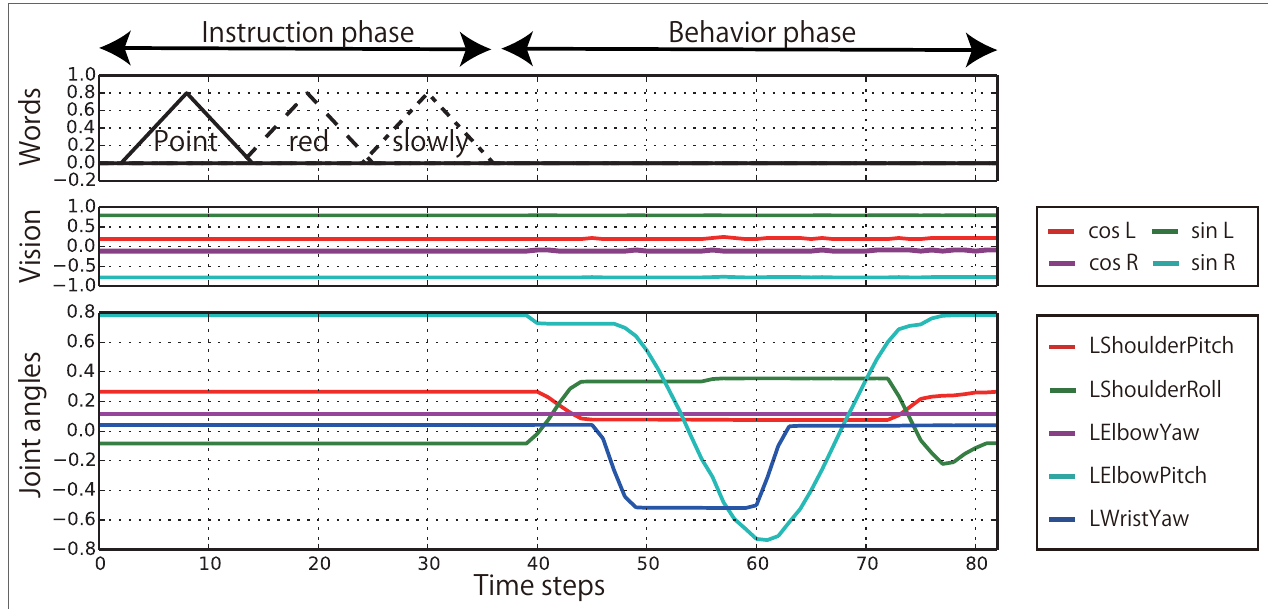
FIGURE 4 | An example of a target sequence representing an episode . In this episode, the robot generates the “POINT-LEFT-SLOWLY” behavior after receiving the instruction “Point red slowly” when the bell arrangement is Red–Green from left to right. Only the five joints of the left arm are plotted.